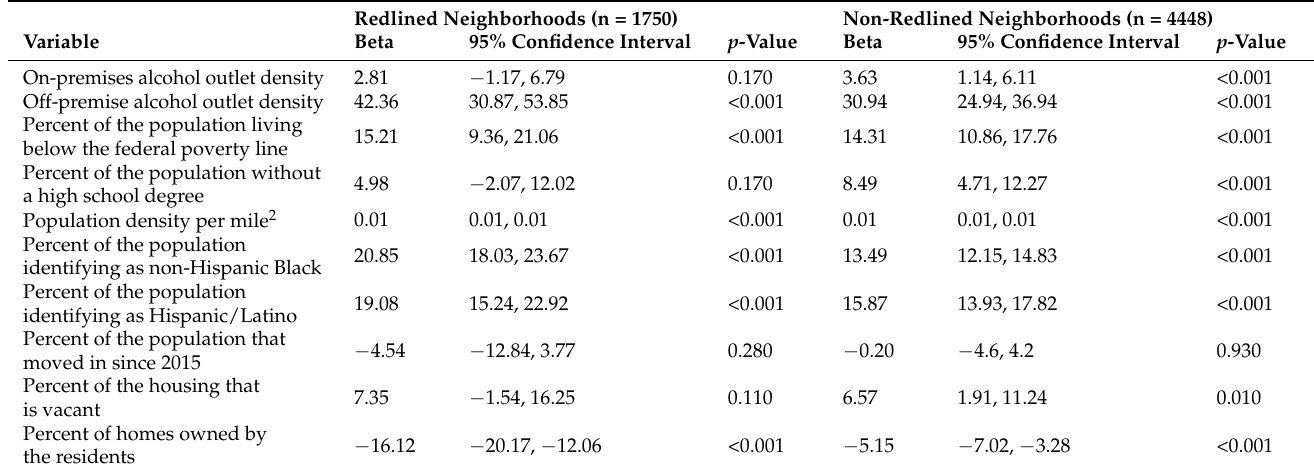
Table 3. Multivariable linear regression model stratified on history of